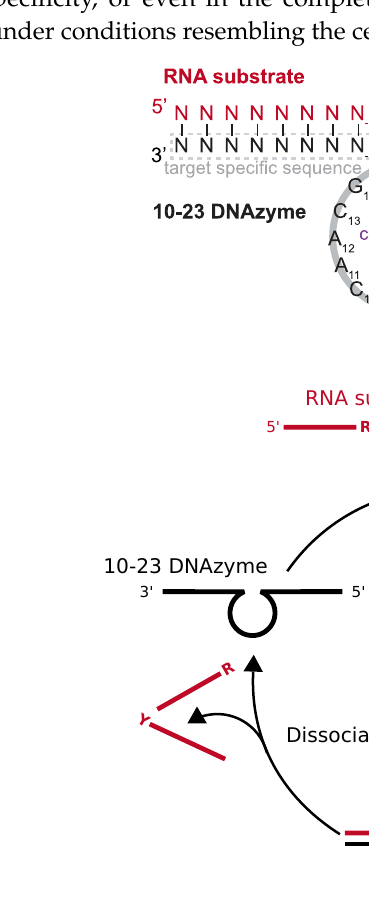
Figure 1. Sequence and reaction scheme of the 10-23 DNAzyme. ( A ) Schematic representation of the 10-23 DNAzyme (indicated in black) with the 15-nt comprising catalytic core bound to the RNA substrate (indicated in red). While in general the binding of the DNAzyme with the RNA substrate occurs via Watson-Crick base pairing ( | ), nucleotides forming wobble base pairs ( ⋅ ) at position − 1 lead to enhanced cleavage. ( B ) RNA cleavage performed by the 10-23 DNAzyme under multiple-turnover onditions. The DNAzyme (black) binds its specific RNA substrate (red), cleaves between two central purine (R) and pyrimidine (Y) nucleotides in a manner dependent on divalent cation(s) M 2 + , and dissociates from the cleaved